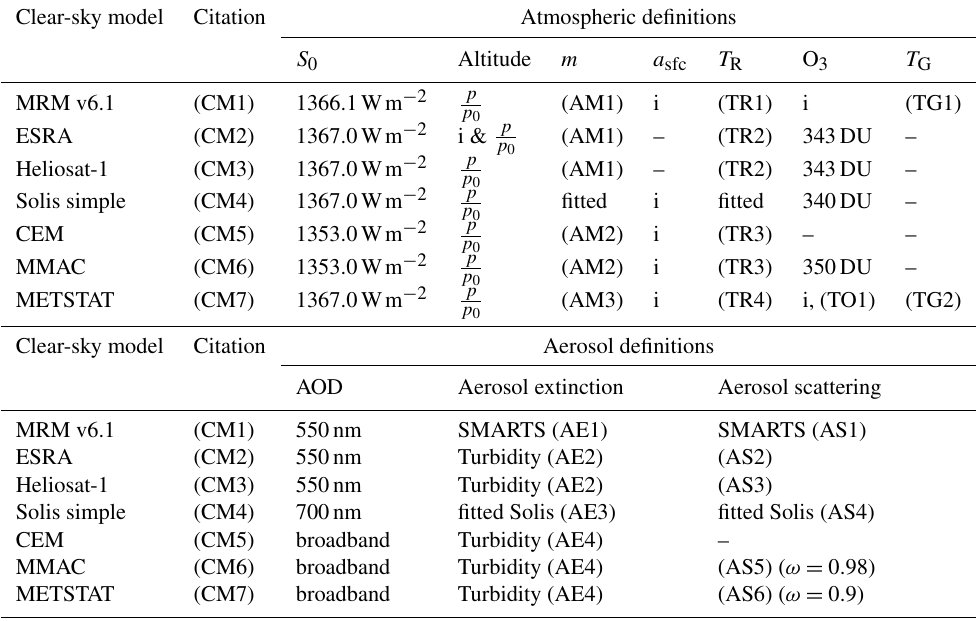
Table 2. The table lists the CSMs used in this study and their definitions, assumptions and considered input parameters. Parameters considered as input are marked with (i). Listed parameters are the assumed solar constant ( S 0 ) and scaling for site altitude, which is usually applied in the definition of air mass ( m ). In addition, the surface albedo ( a sfc ), transmittance from Rayleigh scattering ( T R ), considered ozone column (O 3 ) and transmittance from absorption by mixed gases in the atmosphere ( T G ) are listed. The aerosol representation is listed for its extinction and scattering properties to calculate the direct normal and diffuse irradiance, respectively. Some aerosol scattering functions are based on a fixed SSA ( ω ) value. All models receive measured pressure ( p ) and water vapour column as input. In all models, a standard pressure ( p 0 ) of 1013.25hPa is